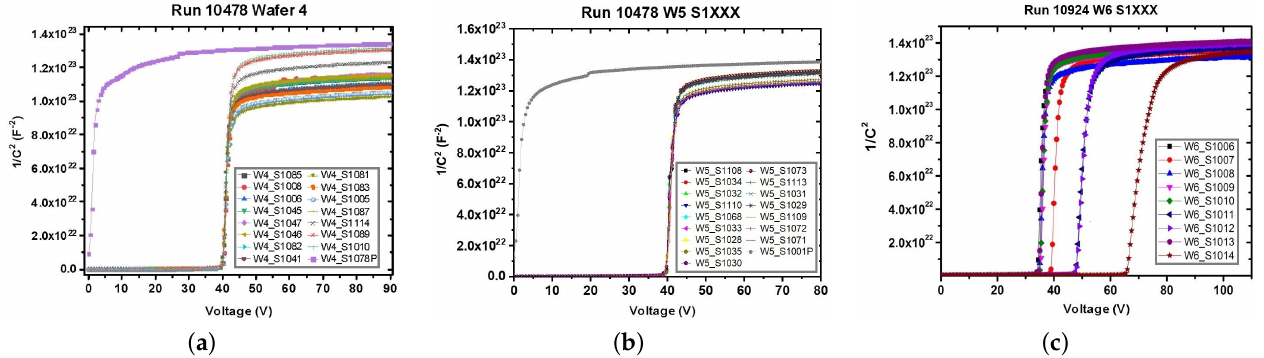
Figure 2. C-V characteristic curves for ( a ) Boron, ( b ) Boron plus Carbon and ( c ) Gallium LGADs performed at room temperature by CNM [12].